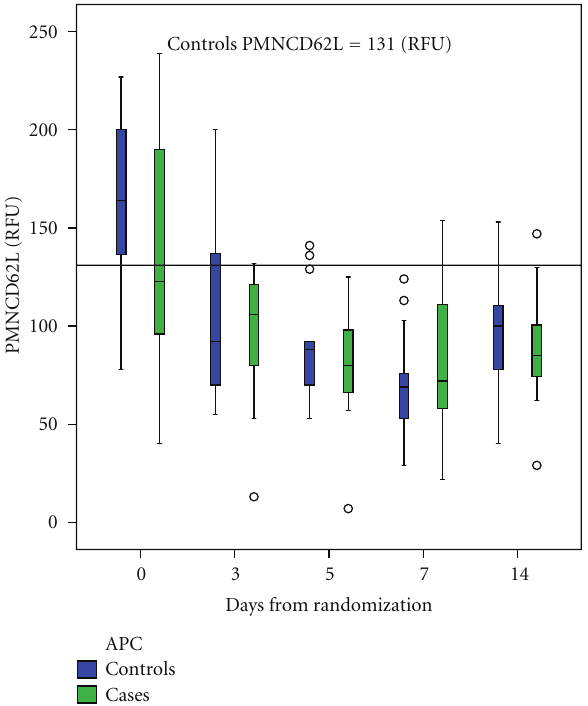
Figure 2: The changes in expression of CD62 on neutrophils during the follow-up time. The APC did not have significant e ff ect on the changes ( P = 0 . 251). Box-Whisker plots show median, interquartile range (box) and highest and lowest values. Outliers (circles) are shown